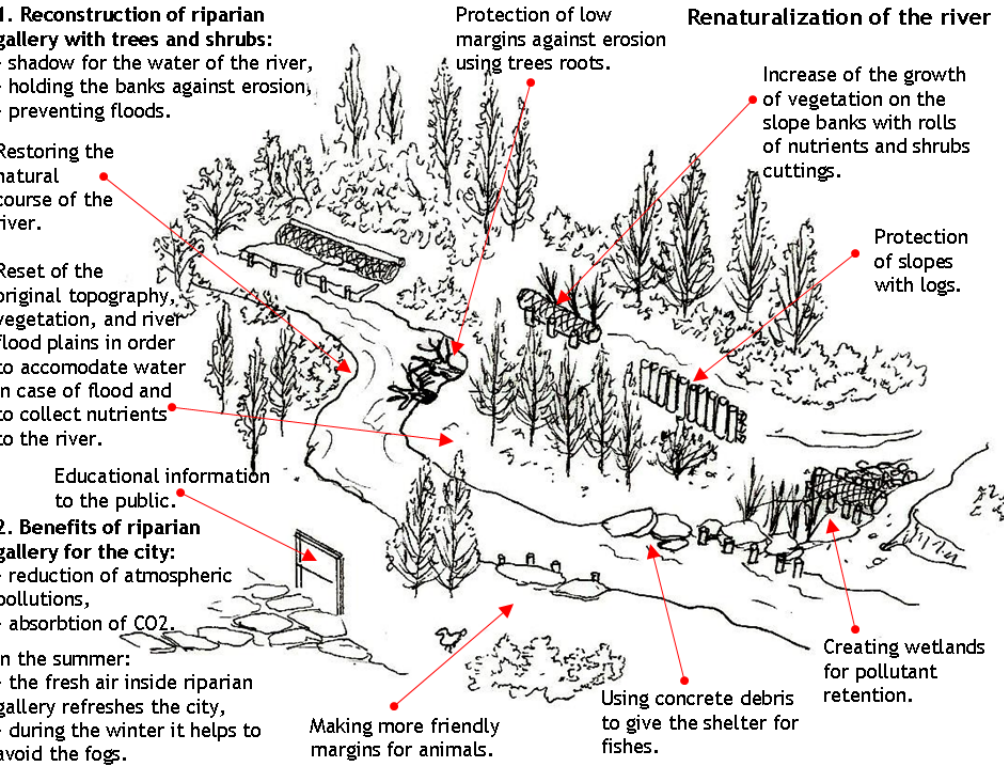
Figure 6a: Attempts to keep the river banks natural by its renaturalization, using various means of garden architecture. “Seeds of native vegetation scattered on top of straw bales create a dense growth of vegetation that keeps the water cool, provides fish a shelter (...)” [11]. In many urban spaces, “so little natural areas are left that the people who live there need to be given opportunities to learn about na- ture” [12].